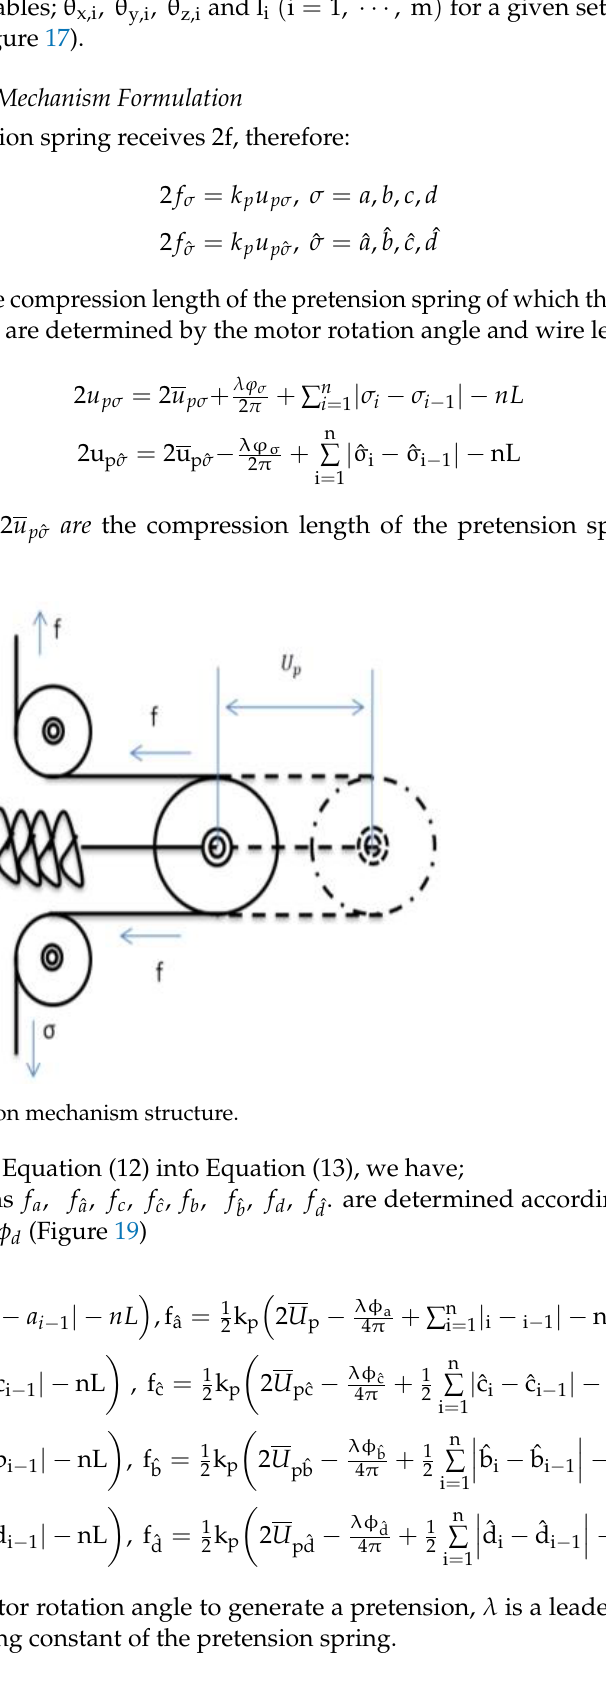
15 of 22 Figure 17. Cable eyelet arrangement for end and mid-section discs. 4.3. C. Pretention Mechanism Formulation